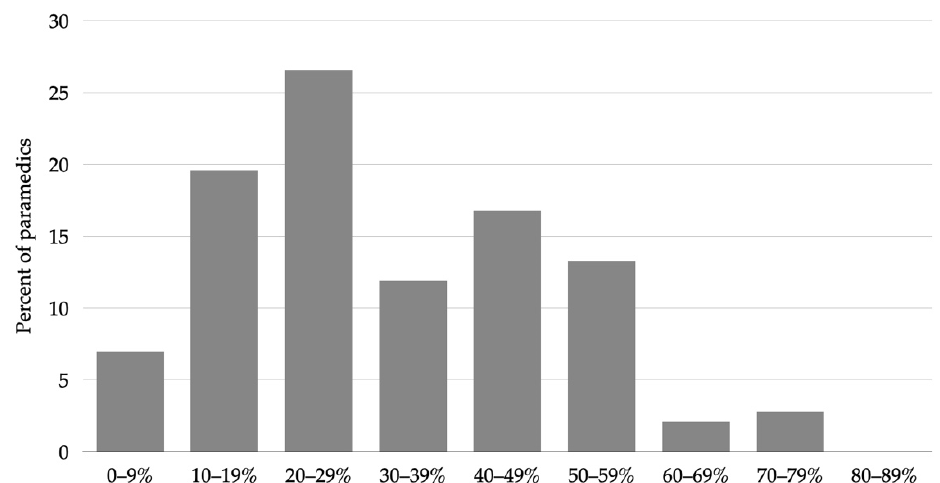
Figure 4. EMS estimate of stroke mimic prevalence in the prehospital setting.